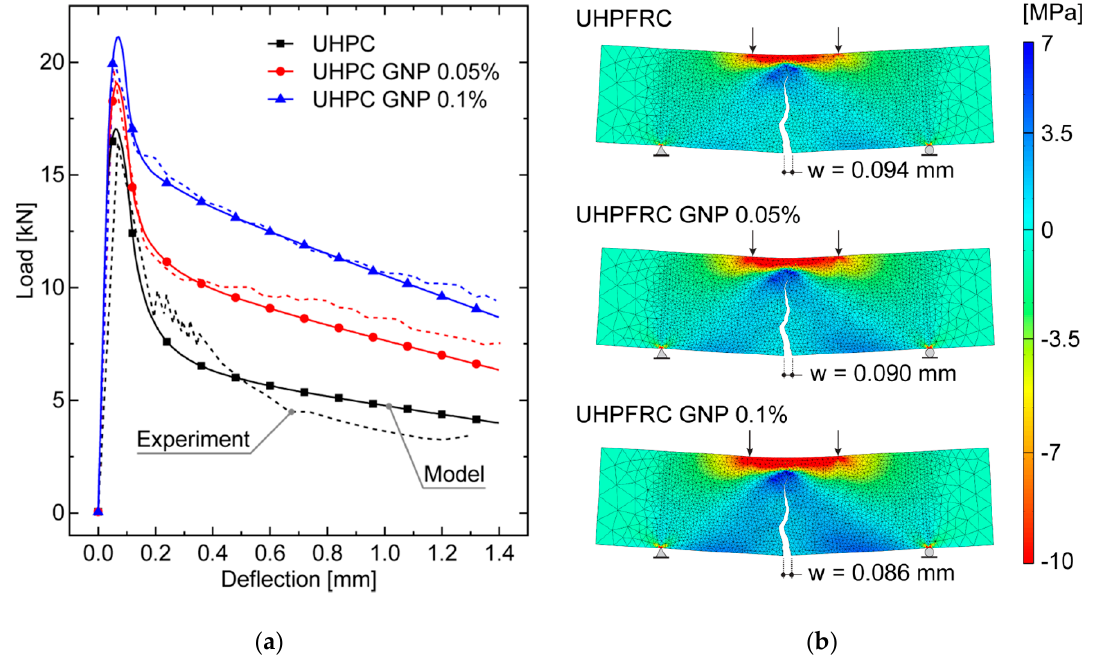
Figure 5. Global structural response for the three considered UHPFRC mixtures: ( a ) comparison between numerical and experimental results in terms of load versus mid-span deflection curves; ( b ) deformed configurations (magnified by a scale factor of 25), horizontal stress maps and main crack paths at a beam deflection of 0.2 mm.